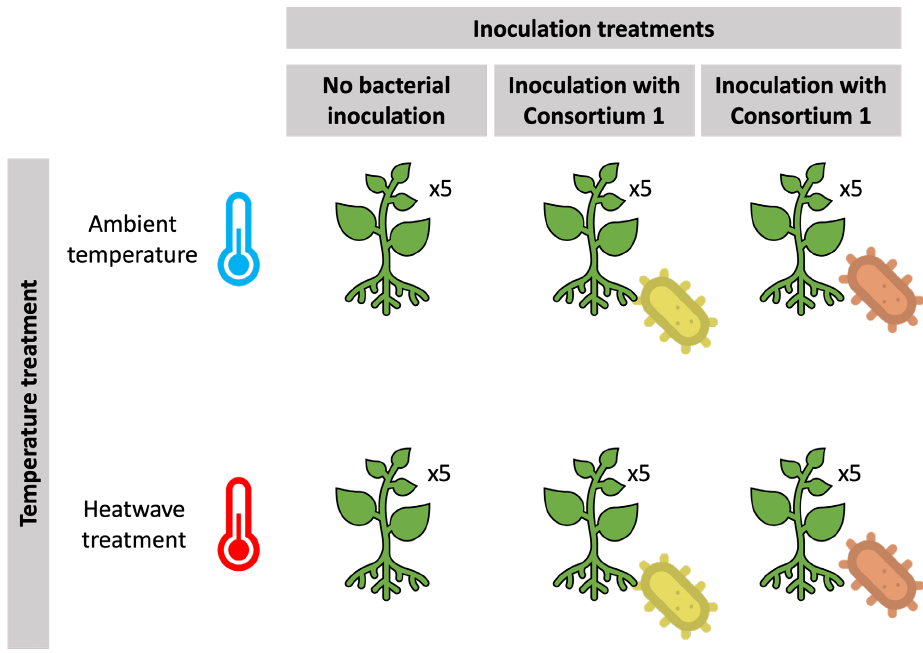
Figure 1. Experimental design of the thermal and inoculation treatments